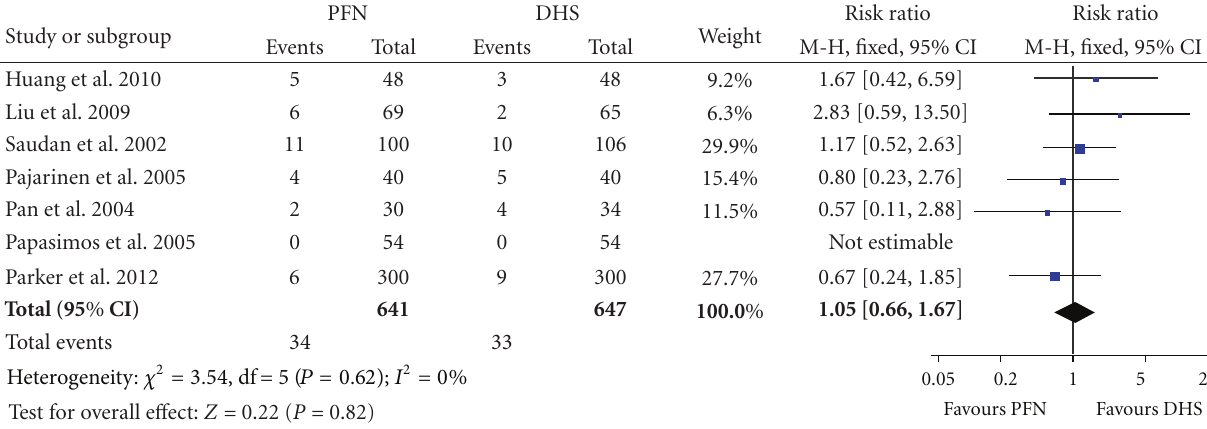
Figure 6: Comparison of wound complication between PFN and DHS.